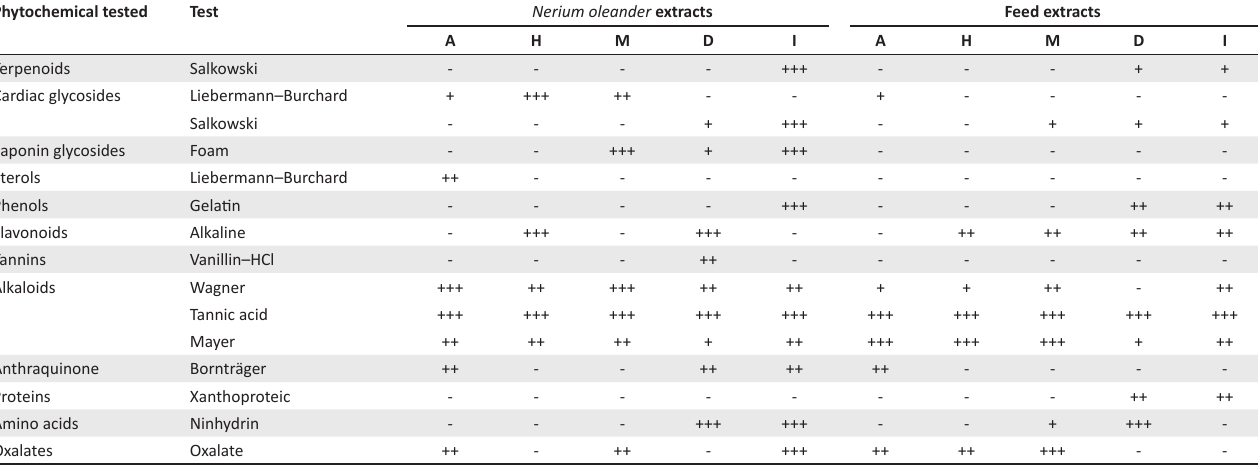
TABLE 1: Qualitative analysis of selected phytochemicals in feeds and Nerium oleander . Phytochemical tested Test